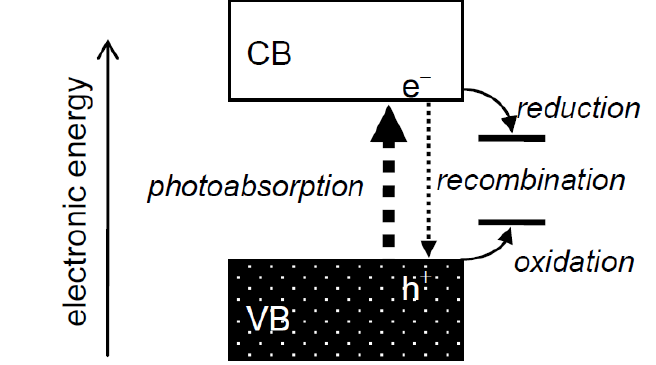
Figure 1. Electronic structure of semiconductor photocatalysts and processes in photocatalytic